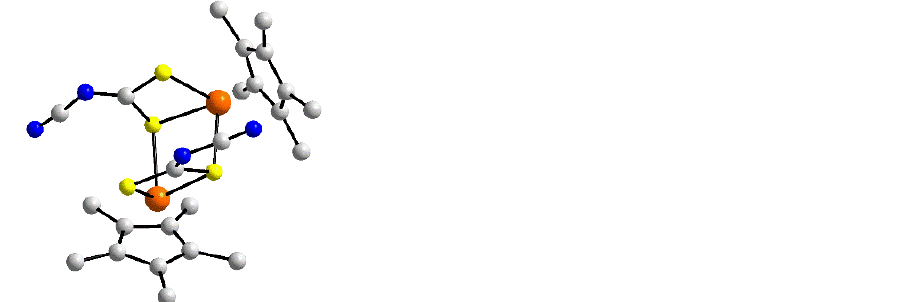
Figure 4. Molecular structure of [(CO) 2 Fe(dppm)Fe(CO) 2 ][S 2 C=N(4-tolyl)] ( 8 ).